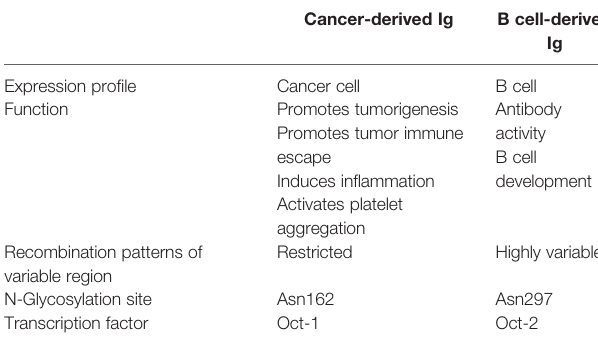
TABLE 2 | Comparison between the characteristics of cancer-derived Ig and B cell-derived Ig.